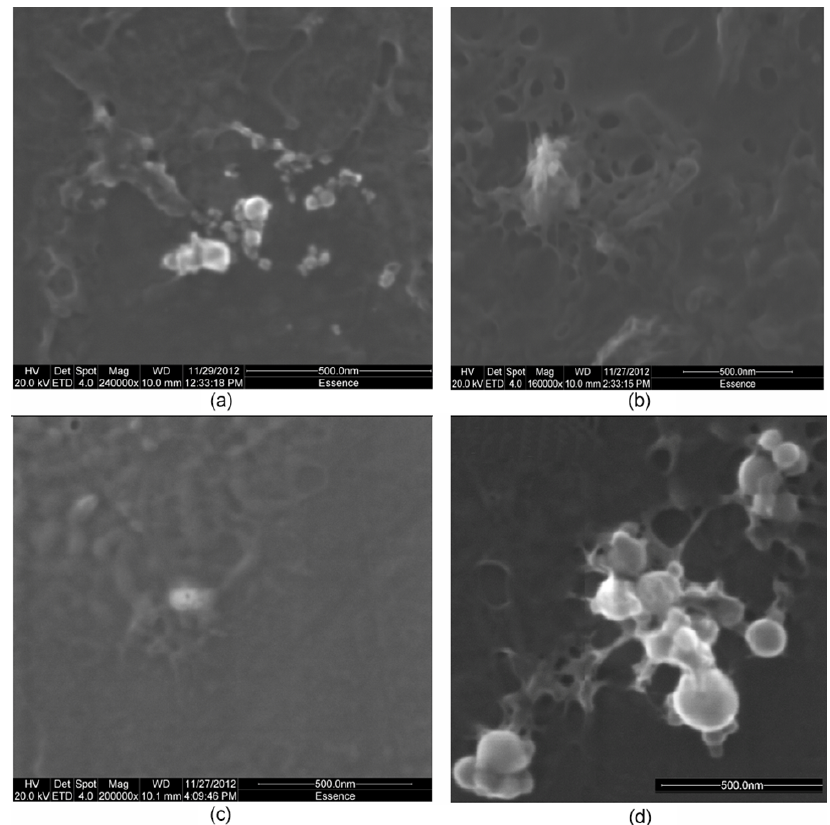
Figure 7. Secondary electron images of refractory particles in the fine fraction of ESSenCe samples: (a) aluminum oxide spheres; (b) Fe-rich particles; (c) Pb-rich particles; (d) Mg-rich